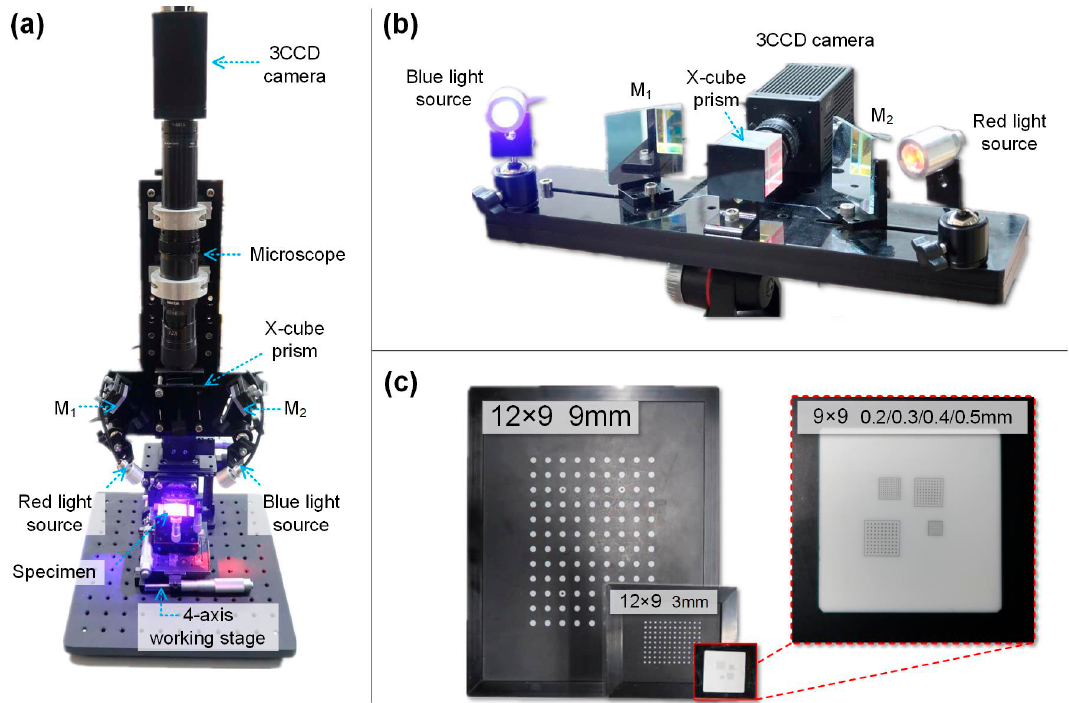
Figure 4. Photographs of ( a ) the established microscopic stereo-DIC system, ( b ) the established regular stereo-DIC system, and ( c ) calibration plates.